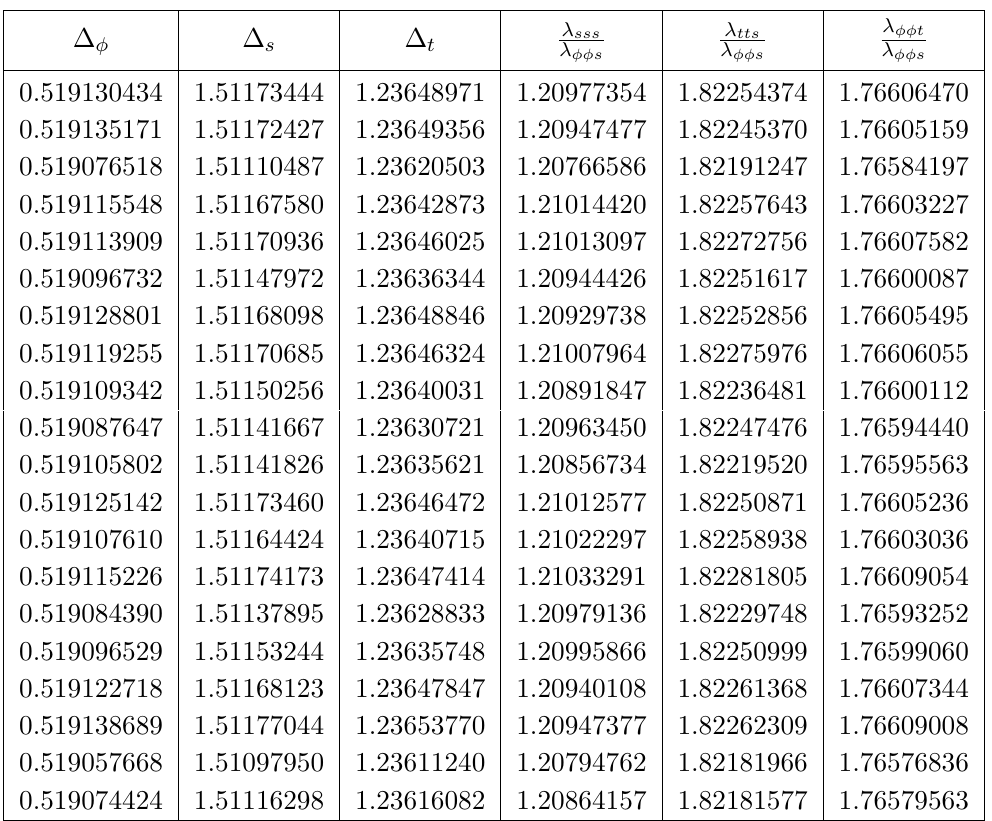
Table 10 . Allowed points in the (cid:3) = 35 island used for obtaining low-lying scalar operator dimensions via the extremal functional